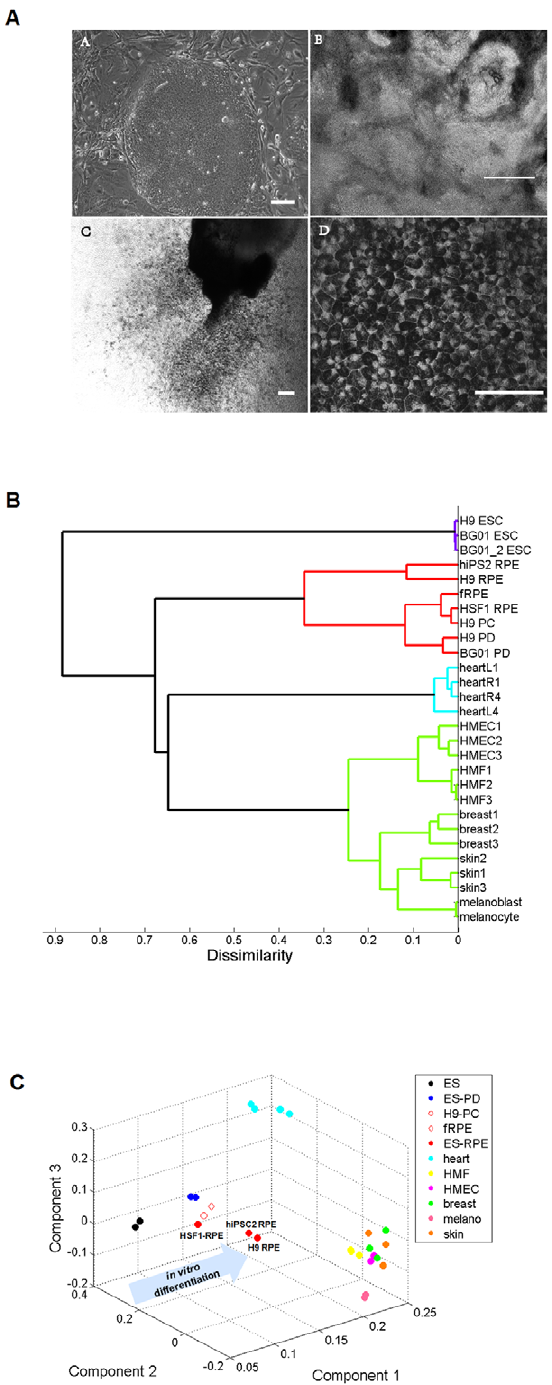
Figure 1. ES-derived RPE have distinctive global miRNA signatures. A) Morphological features of four stages during human pluripotent stem cells differentiate into RPE cells. a, human ES cells; b, partially differentiated ES cells after 4 days withdraw bFGF; c, pigment cluster appeared after about 30 days differentiation; d, RPE monolayer. Scare bar: (a–c) 100 m m; (b) 50 m m. B, C) MiRNA profiles of different cell types were clustered using either unbiased hierarchical clustering or principal component analysis (PCA). B) Pearson correlation clustering between all cell lines. C) 3D-biplot of the first three principal components. Various somatic tissues were downloaded from GEO database.